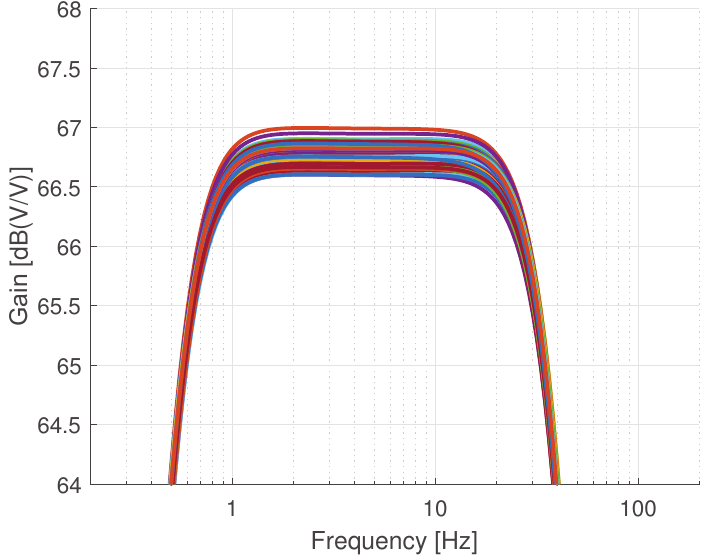
Figure 13. Magnitude response of the Monte Carlo simulation samples of the last stage of circuit 1. Each line plot represents a different Monte Carlo